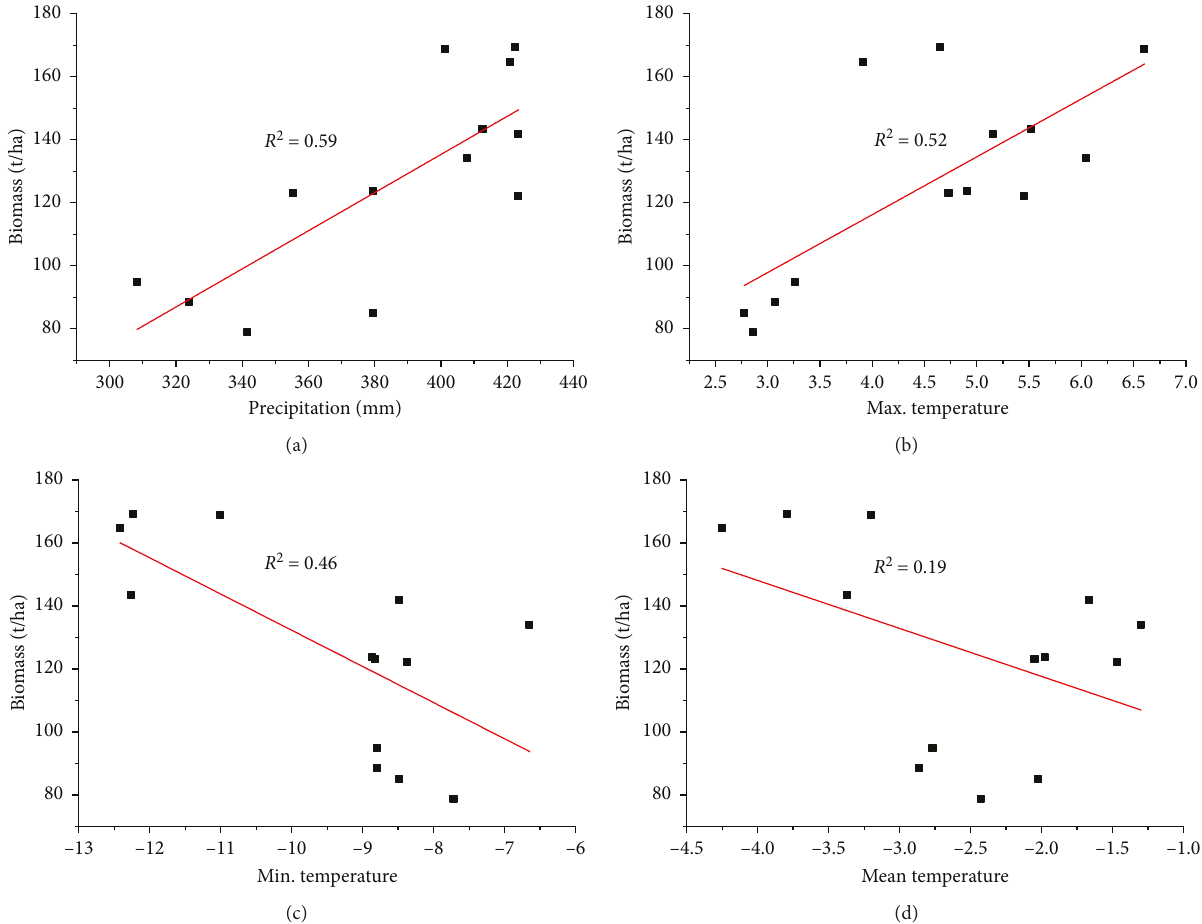
Figure 6: Relationship between Betula platyphylla stem biomass (SB) with > 430 mm (PPT) along climatic gradients from 1950 to 2016: (a) annual precipitation; (b) annual maximum temperature; (c) annual minimum temperature; (d) annual mean